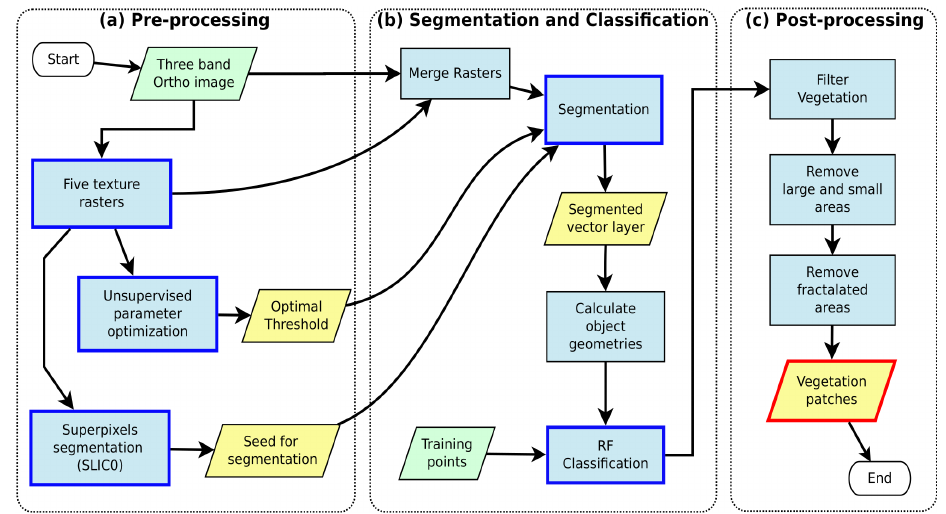
Figure 2. Flow diagram of the object-based image analysis